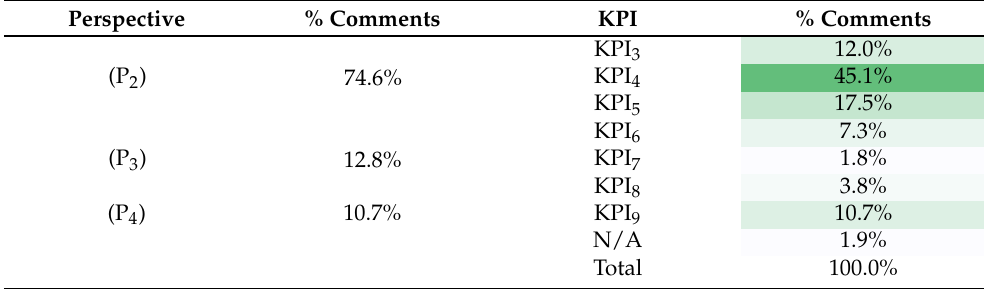
Table 4. Percentage of opinions categorized in the KPIs and